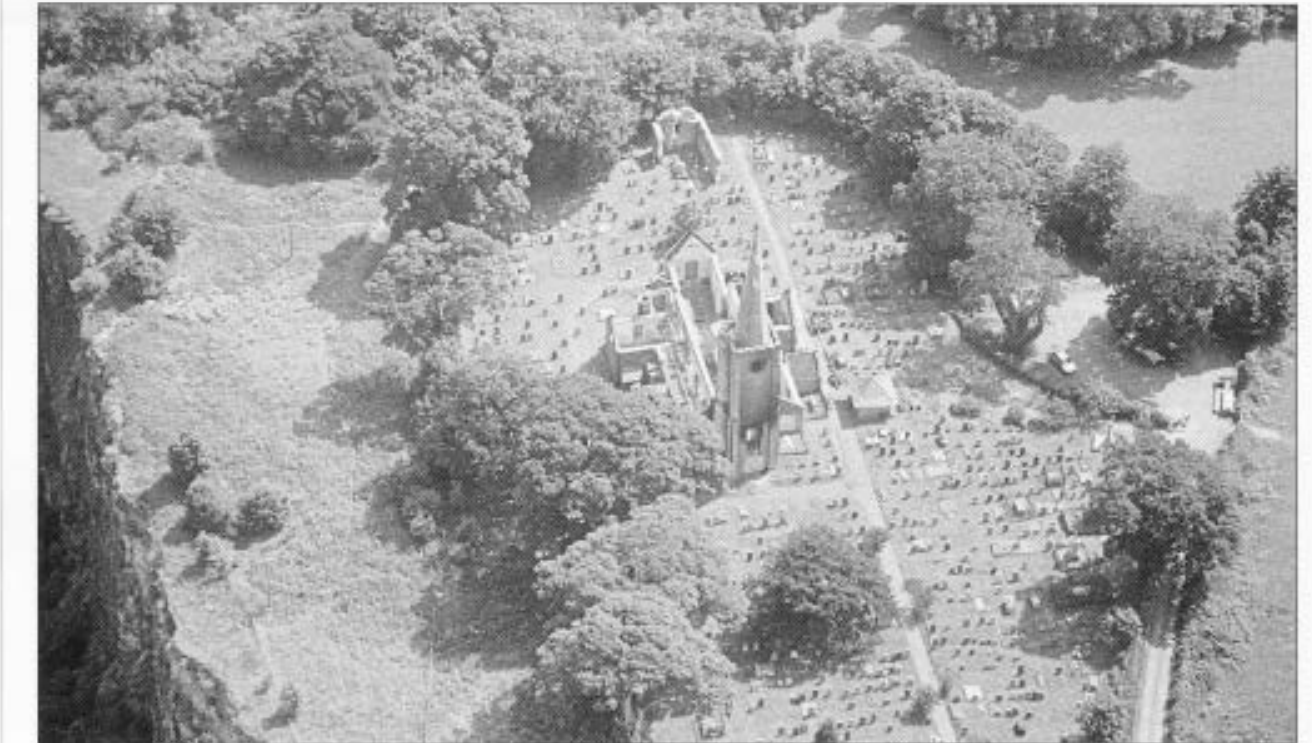
Aerial photograph of the ruins of Holy Trinity church, its graveyard and (at the extreme left) the edge of a nearby quarry; the small ruin aligned with the church at the eastern end of the graveyard may be part, or on the site, of an early medieval monastic